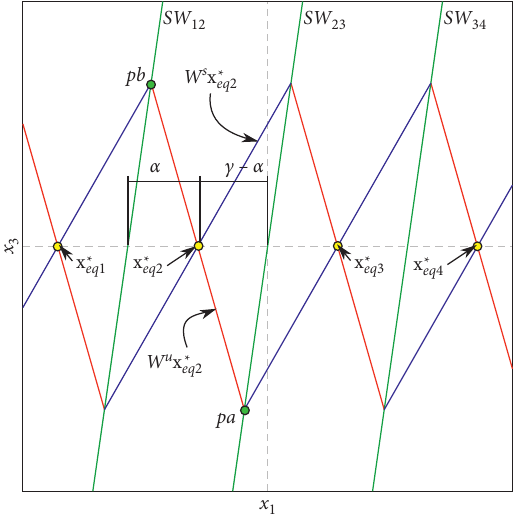
Figure 1: In (a) the heteroclinic loop of the system (1), (3), (5), and (6) with the switching surface x ∈ R 3 : 2 x a � 0 . 2 ,b � 5 , c � − 3 , α � 1, and the initial conditions x � ( 0 . 9999976751050959 , 0 , 2 . 3248949041393315 e − 6 ) T (blue), and in (b) a double-scroll attractor that emerges from a heteroclinic orbit x 02 using the following initial condition x